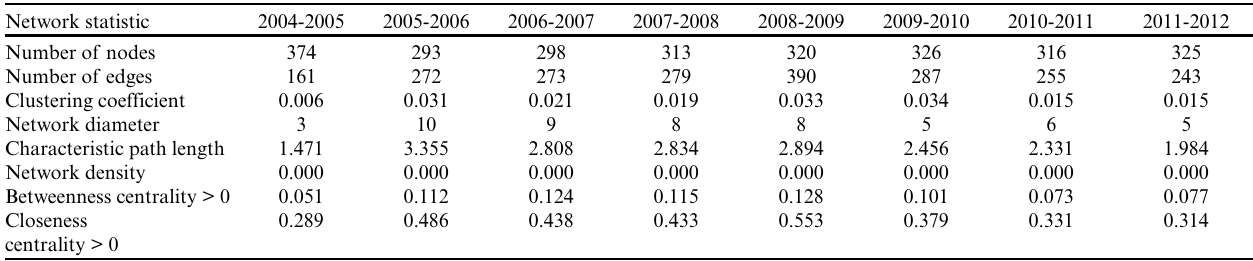
Table 2 . Selected statistics for the coral trout (CT) lease trade